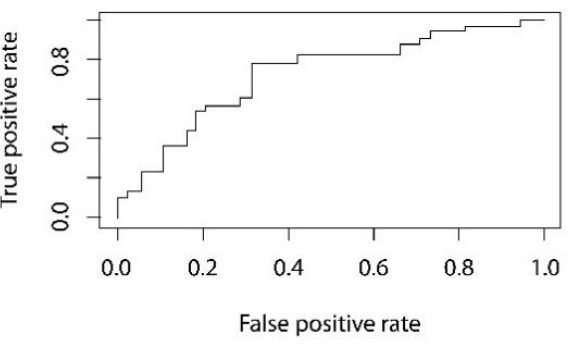
Figure 4. ROC analysis of the discrimination accuracy of the ANN. A threshold of 0.65 was used to optimize true-positive and false-positive rates.